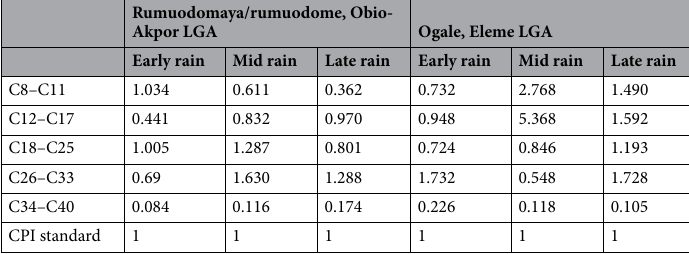
Table 6. Carbon preference index (CPI) of TPHs